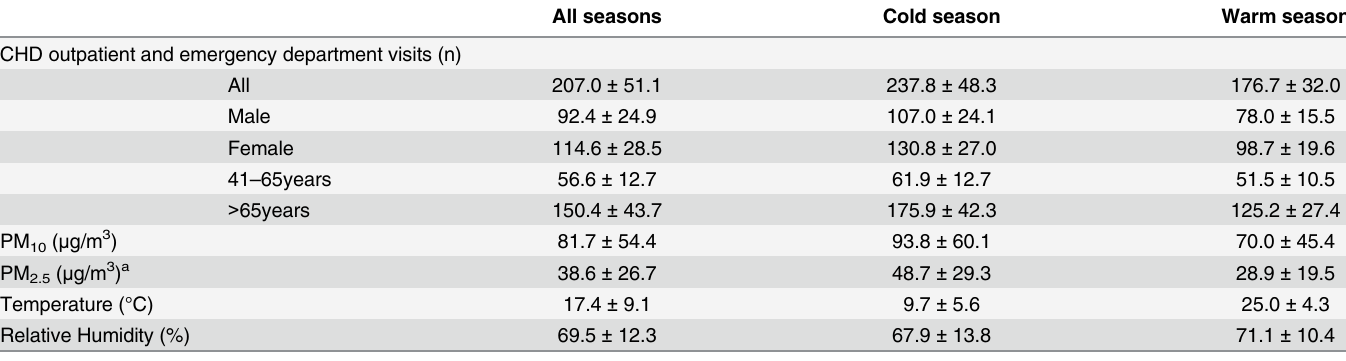
Table 1. Summary (mean ± SD) of daily CHD outpatient and emergency department visits, PM concentrations and weather conditions in Shanghai in 2005 – 2012.